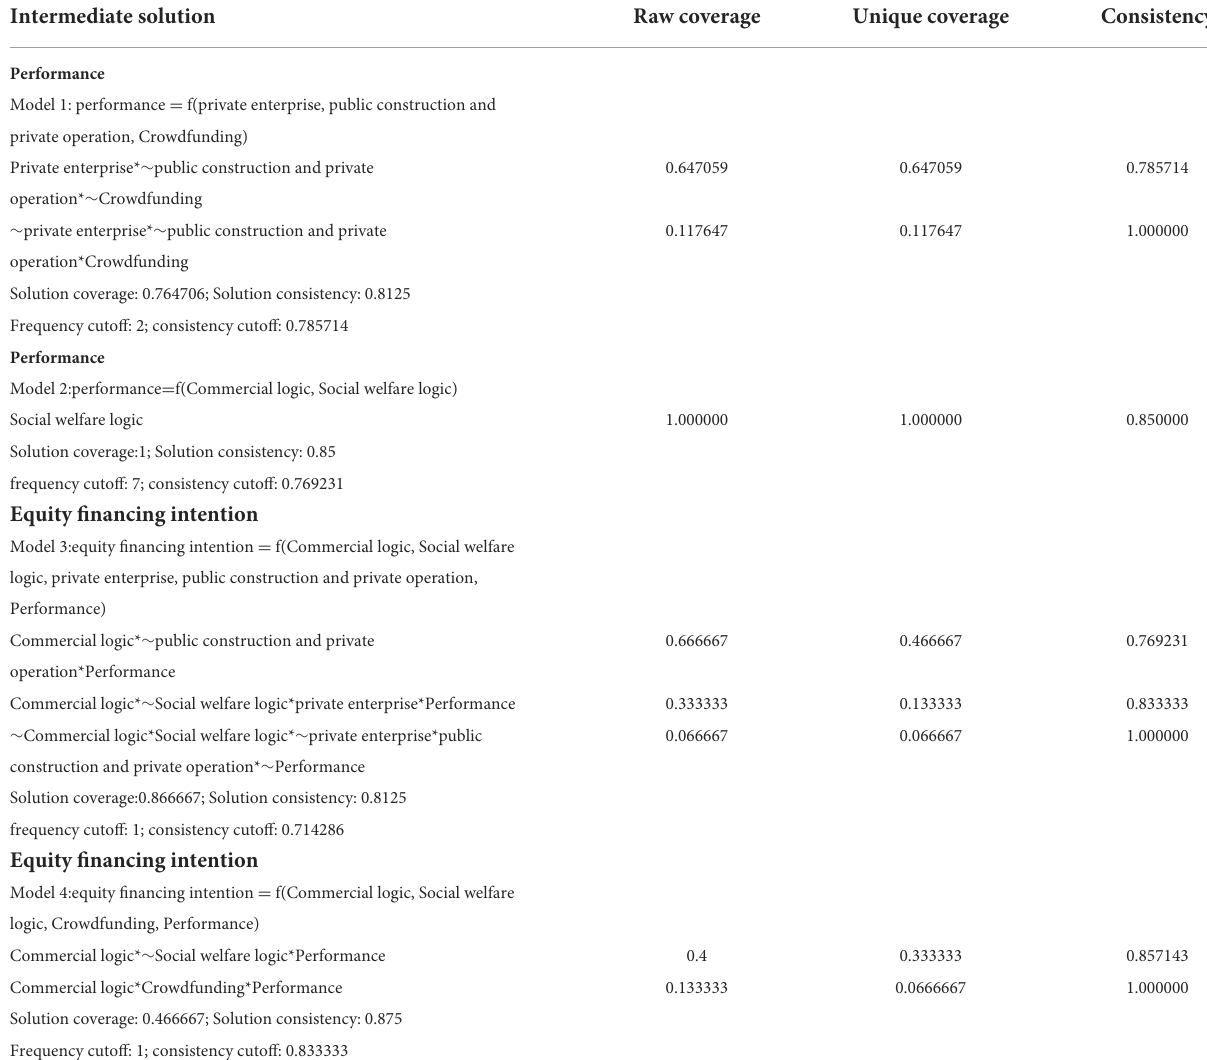
TABLE 1 Intermediate solution for the introduction of investment by elderly care